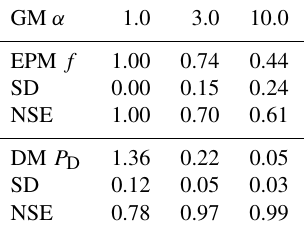
Table 1. Comparison of the shapes of the gamma (GM), exponen- tial piston flow (EPM), and dispersion (DM) model transit time dis- tributions. The shape parameters of the best-fitting versions of the other models and the goodness of fit (standard deviation, SD; Nash– Sutcliffe efficiency, NSE) between them and the GM are given. GM α